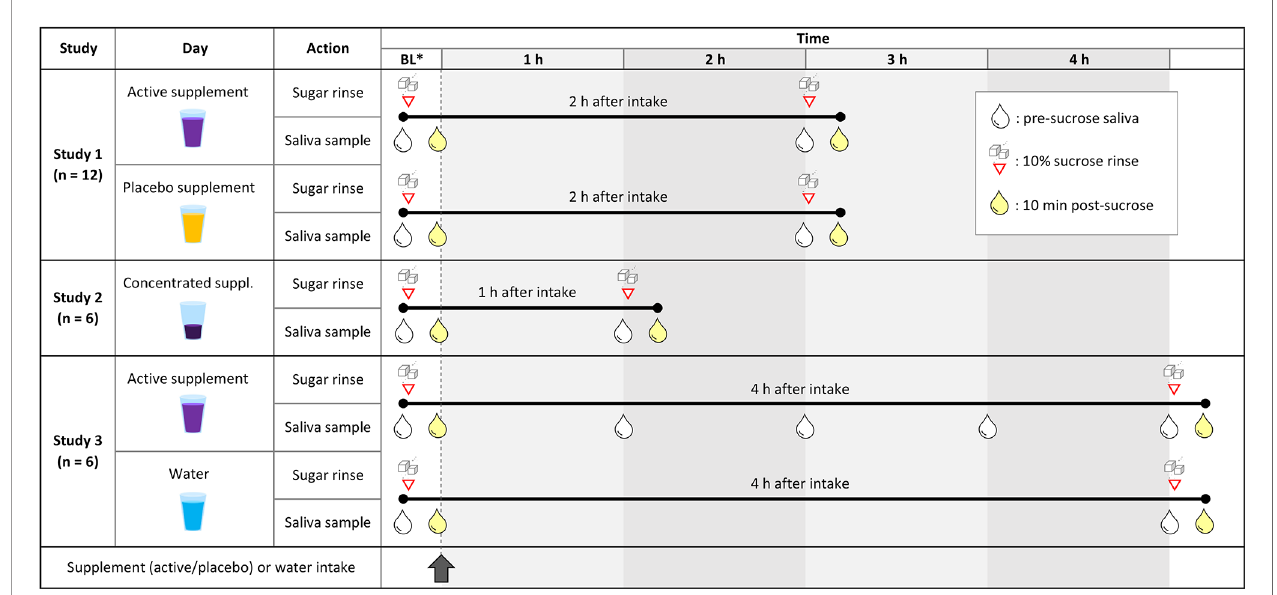
FIGURE 1 | Design of the different clinical studies included in this article. Study 1: Cross-over study design in which 12 individuals received a nitrate-rich supplement (250 mg nitrate in 200 ml) on one day and a nitrate-poor placebo (<6 mg nitrate in 200 ml) on the same day a week earlier (individuals 1-6) or later (individuals 7-12). The effects of both supplements on sucrose rinses were compared. Study 2: Six individuals received a concentrated beetroot extract (300 mg nitrate in 70 ml) to compare the effect of a sucrose rinse before and 1 h after supplement intake. Study 3: Another six individuals received a nitrate rich-supplement (220 mg nitrate in 200 ml) and saliva was taken every hour to monitor changes in physiological parameters. Additionally, the effect of a sucrose rinse after 4 h of supplement intake was compared to a sucrose rinse 4 h after water intake (200 ml) on the previous day. BL, baseline (before supplement intake). Red triangles with sugar cubes show when 10% sucrose rinses were performed, and the drops represent saliva sampling. White drops are saliva samples taken right before a sucrose rinse or without a subsequent sugar, and yellow drops are 10-minute post-sucrose rinse saliva